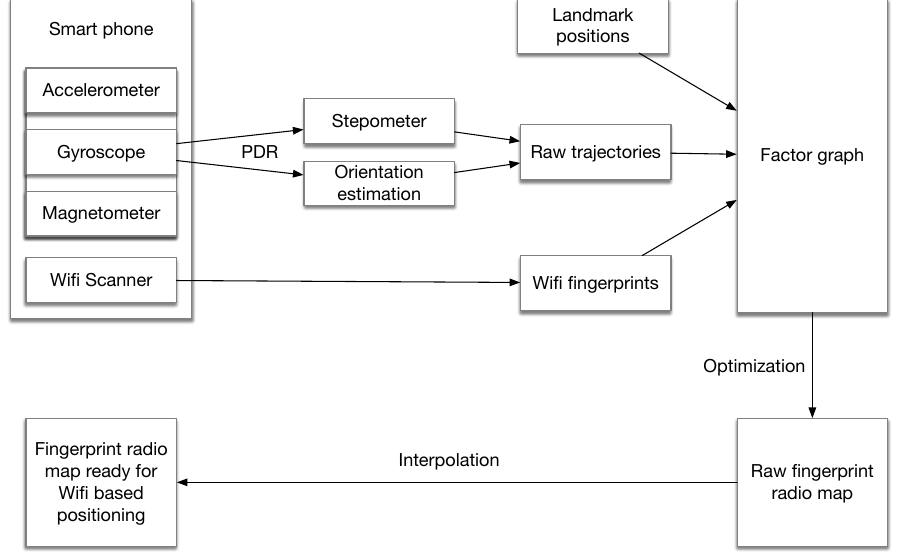
Figure 1. An overall processing flow for the proposed fingerprint radio map